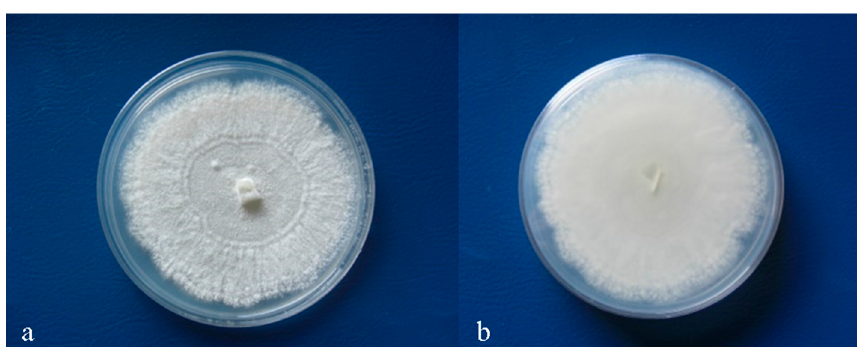
Figure 2. Colony of O . novo-ulmi grown on PDA at 22°C two weeks after inoculation: ( a ) Upper surface of the colony; ( b ) reverse surface of the